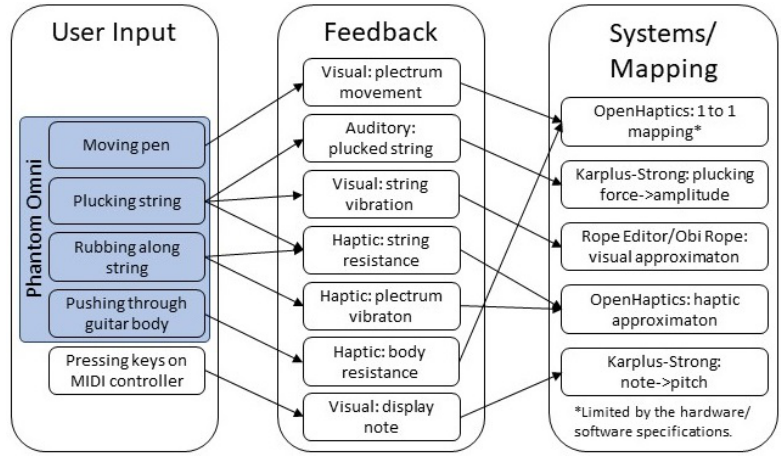
Figure 2. Overview of the interaction design components and related software